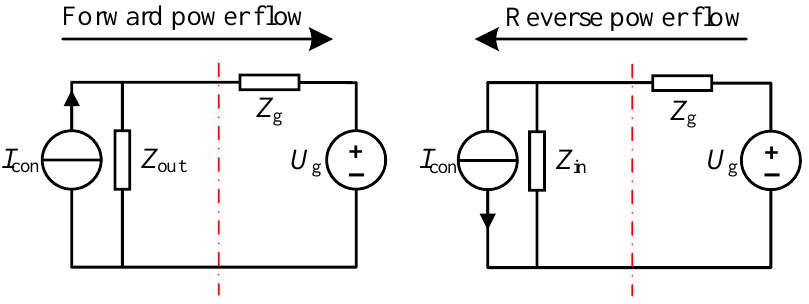
Figure 6. Thevenin Norton equivalent circuit of bidirectional grid-connected converter system under conventional direct power control.